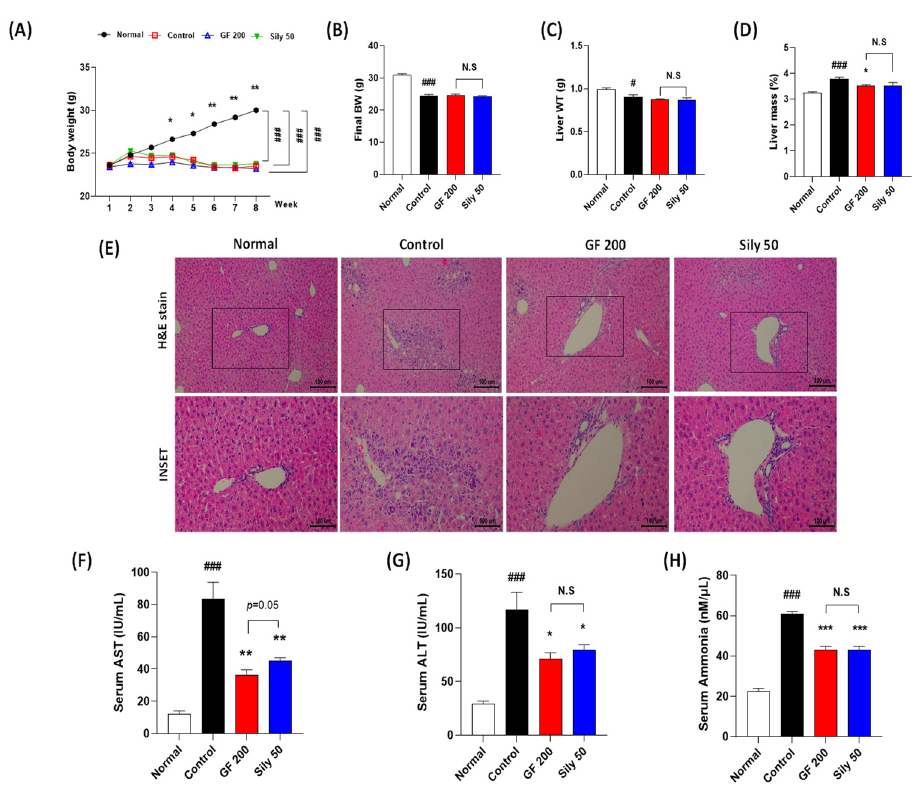
Figure 1. Effects of GF on the TAA-injected liver fibrosis of mice model. General outcomes for ( A ) body weight changes, ( B ) final body weight, ( C ) liver tissue weights, and ( D ) relative liver weights. ( E ) Histopathological examinations of H&E stain. ( F ) Serum AST, ( G ) ALT, and ( H ) ammonia levels. Data were expressed mean ± SEM ( n = 9 for each group). N.S, not significant, # p < 0.05 and ### p < 0.001 for Normal vs. Control; * p < 0.05, ** p < 0.01, and *** p < 0.001 for Control vs. GF 200 or Sily 50. H&E staining images were captured by light microscope condition (100- or 400-× magnifications).